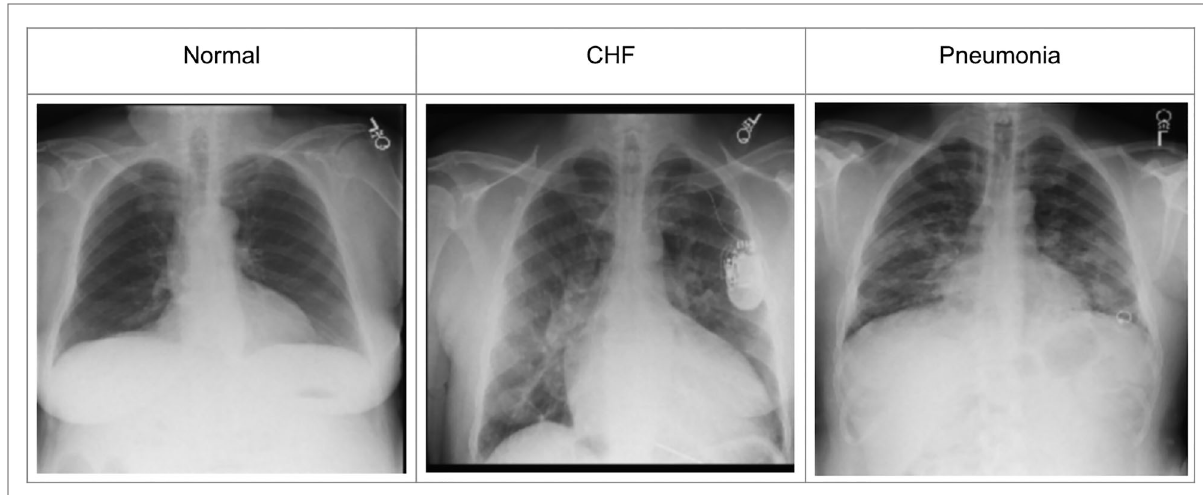
FIGURE 1 Example CXR images for each of the three classes from (12).